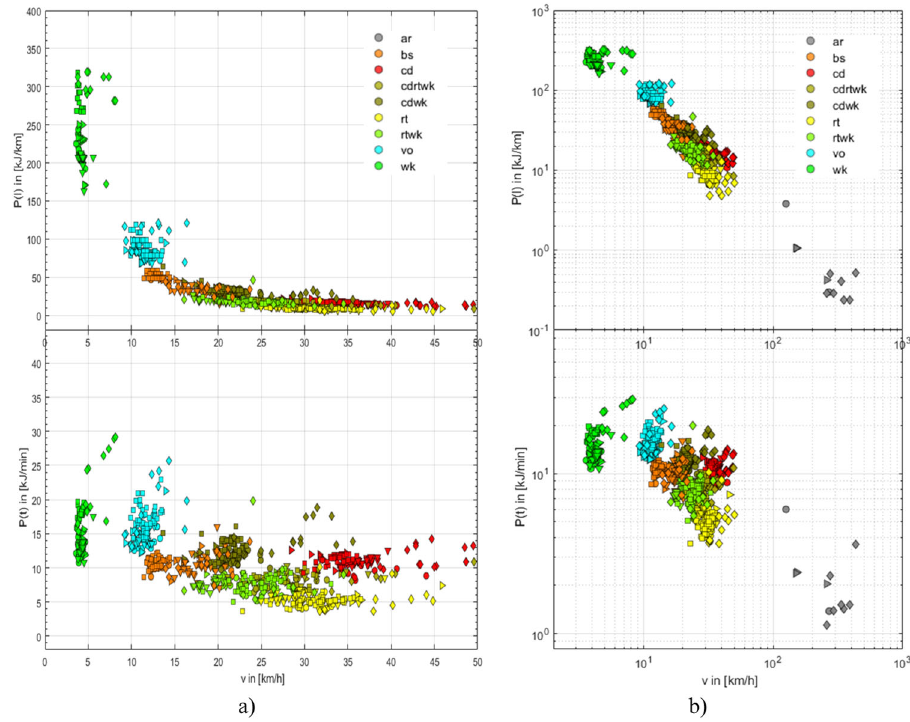
Fig. 8 Time-distance-energy-space. Power of distance and time over speed of selected modes of transport in linear a and double logarithmic b representation. The fi gure is actually a 3-dimensional plot in horizontal ( P m ( t ) — bottom) and vertical ( P m ( l ) — top) projection over travel speed, showing modal human behaviour in a time – distance – energy –